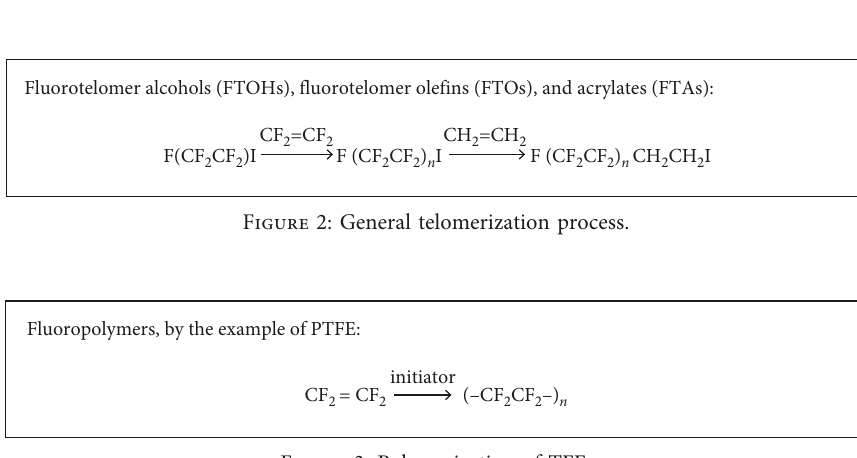
Figure 1: General ECF process: (a) A—PFSAs; (b) B—PFCAs.